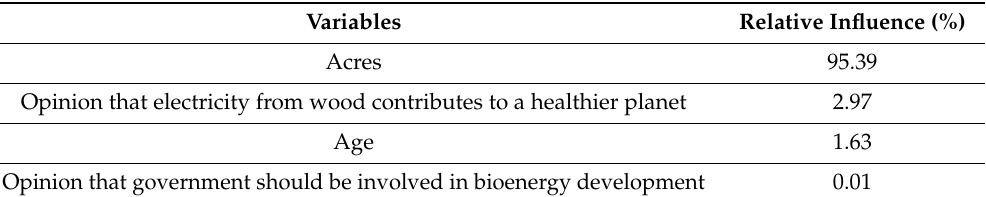
Table 7. Variables and their relative influence on landowners’ acreage commitment to produce.